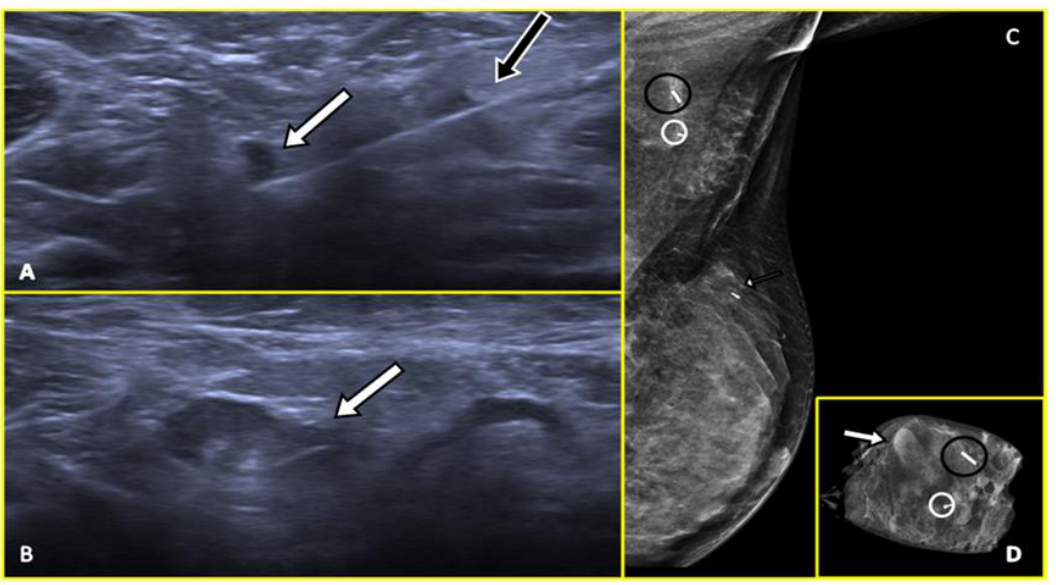
Figure 6. A 28-year-old patient with left breast cancer in the upper-outer quadrant and ipsilateral left axillary node metastasis treated with neoadjuvant chemotherapy. Ultrasound images ( A,B ) show the deployment of the magnetic seed in the pathological axillary node (white arrows) through an 18-gauge steel needle (black arrow). Subsequently, the medio-lateral oblique left mammogram ( C ) depicts the correct localization of the node with the magnetic seed (black circle). It is also visible the marker clip in the node (white circle) and the marker clip in the tumor of the upper-outer quadrant (white thin arrow), placed before the beginning of neoadjuvant treatment. The post-surgical specimen mammogram ( D ) confirmed the presence of the two markers (black and white circle) located in the pathological node (white thick arrow).